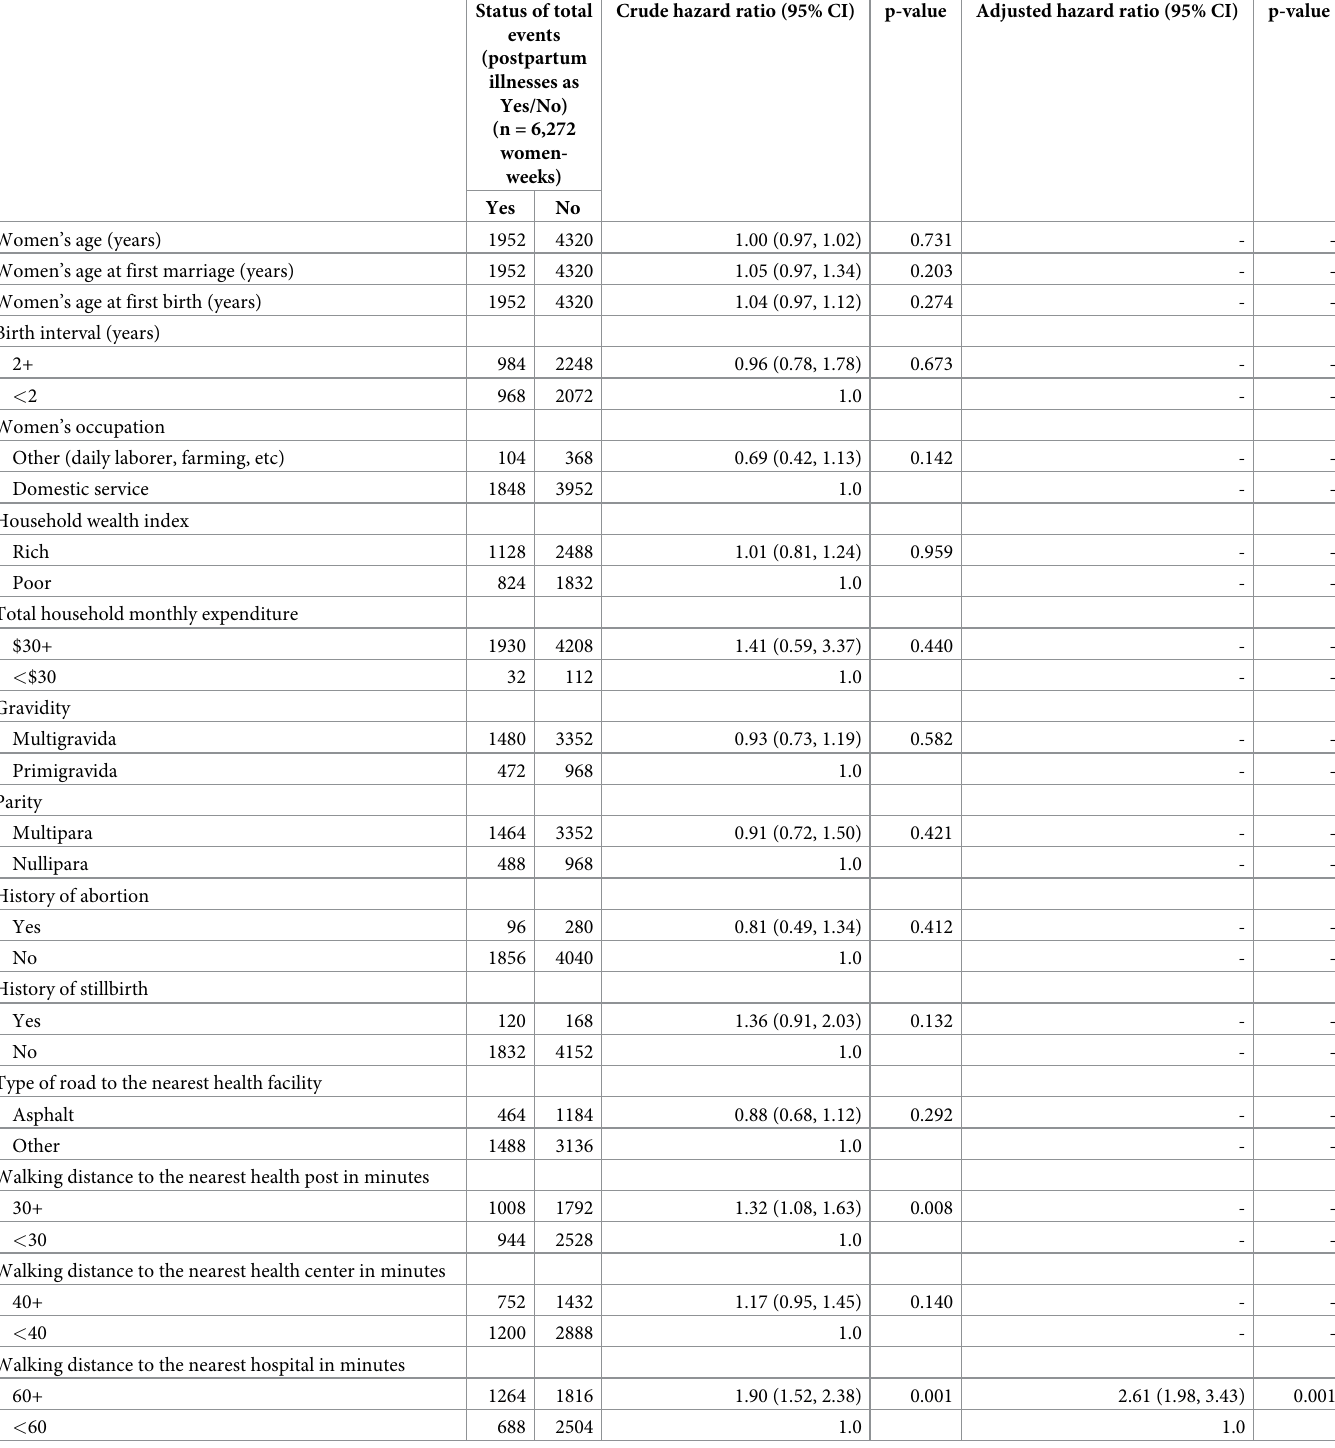
Table 3. Prentice, Williams, and Peterson’s total time Cox-type survival model analysis for postpartum illnesses in rural southern Ethiopia, May 2017 to July